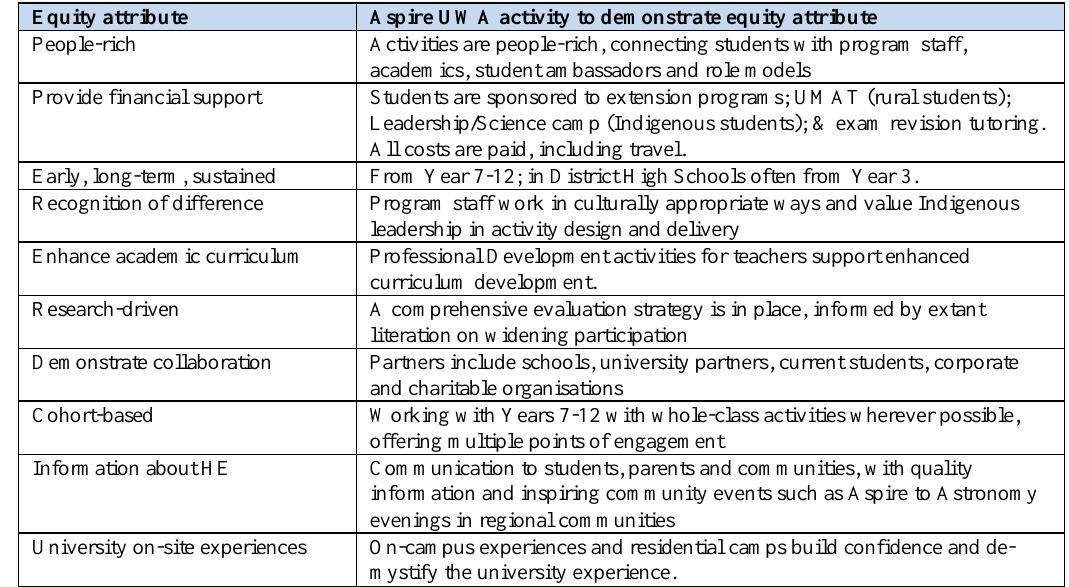
Table 5: Aspire UWA’s alignment with the